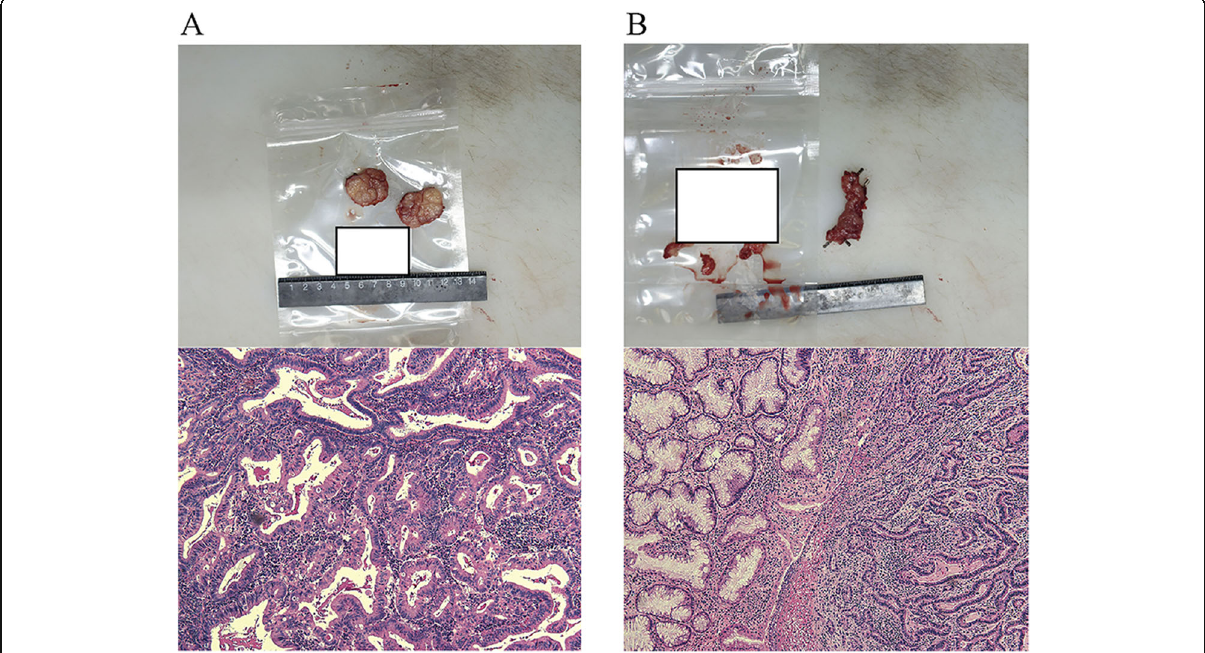
Fig. 4 Gloss pictures and histopathological mappings (H&E stain, magnification × 100) of a the metastasized lymph node and b GC